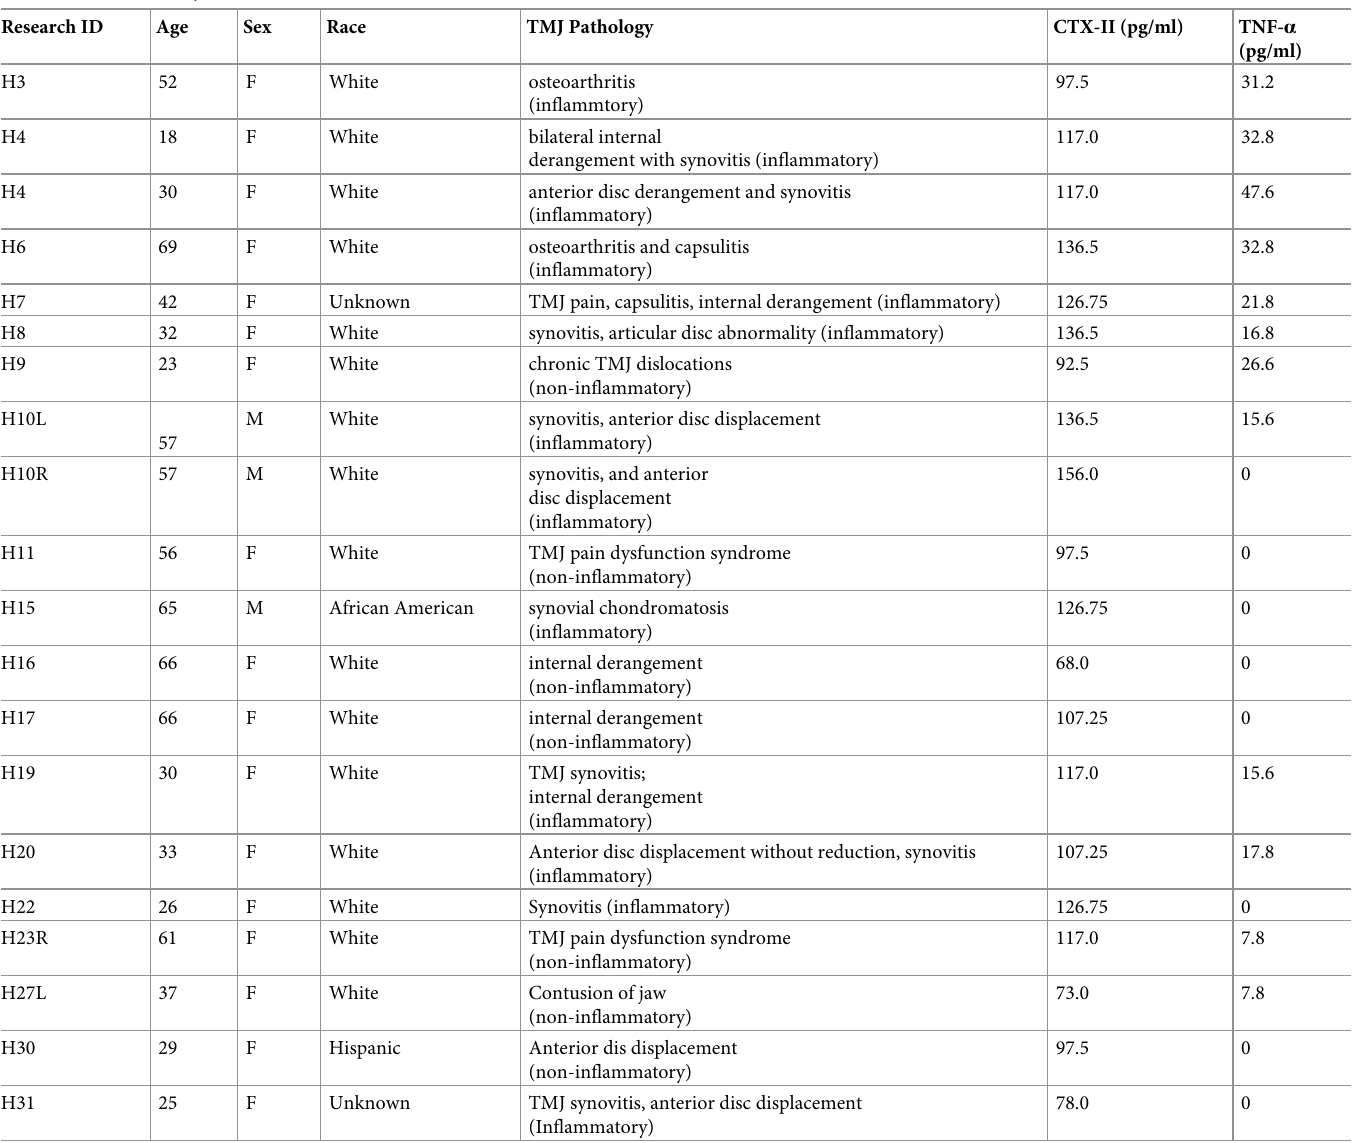
Table 1. Human TMJ synovial